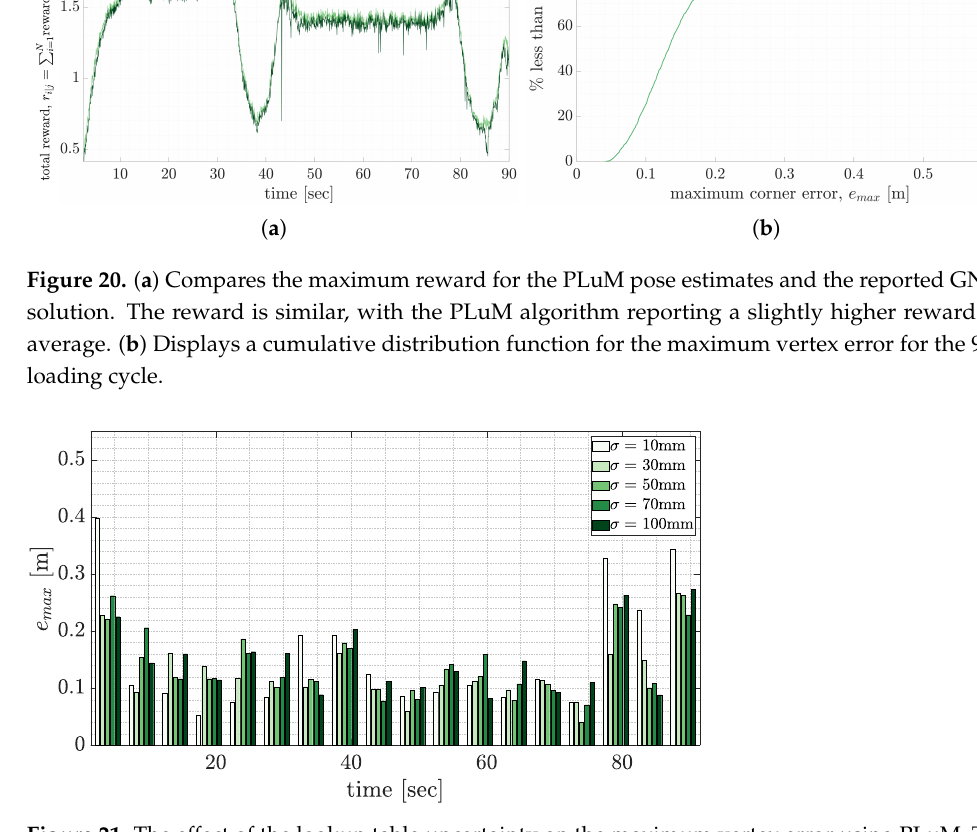
Figure 21. The effect of the lookup table uncertainty on the maximum vertex error using PLuM. The result for every 100th scan is displayed for visualisation purposes. Each darker colour in a group represents an increasing lookup uncertainty, σ , from 10 mm to 100 mm. The lookup tables were generated with a resolution of ∆ 10 =